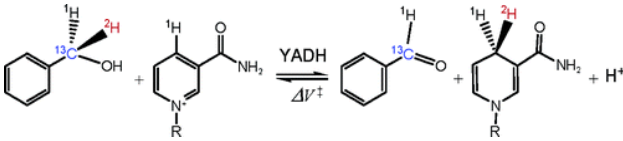
Figure 2. The scheme of the hydride ion transfer reaction.